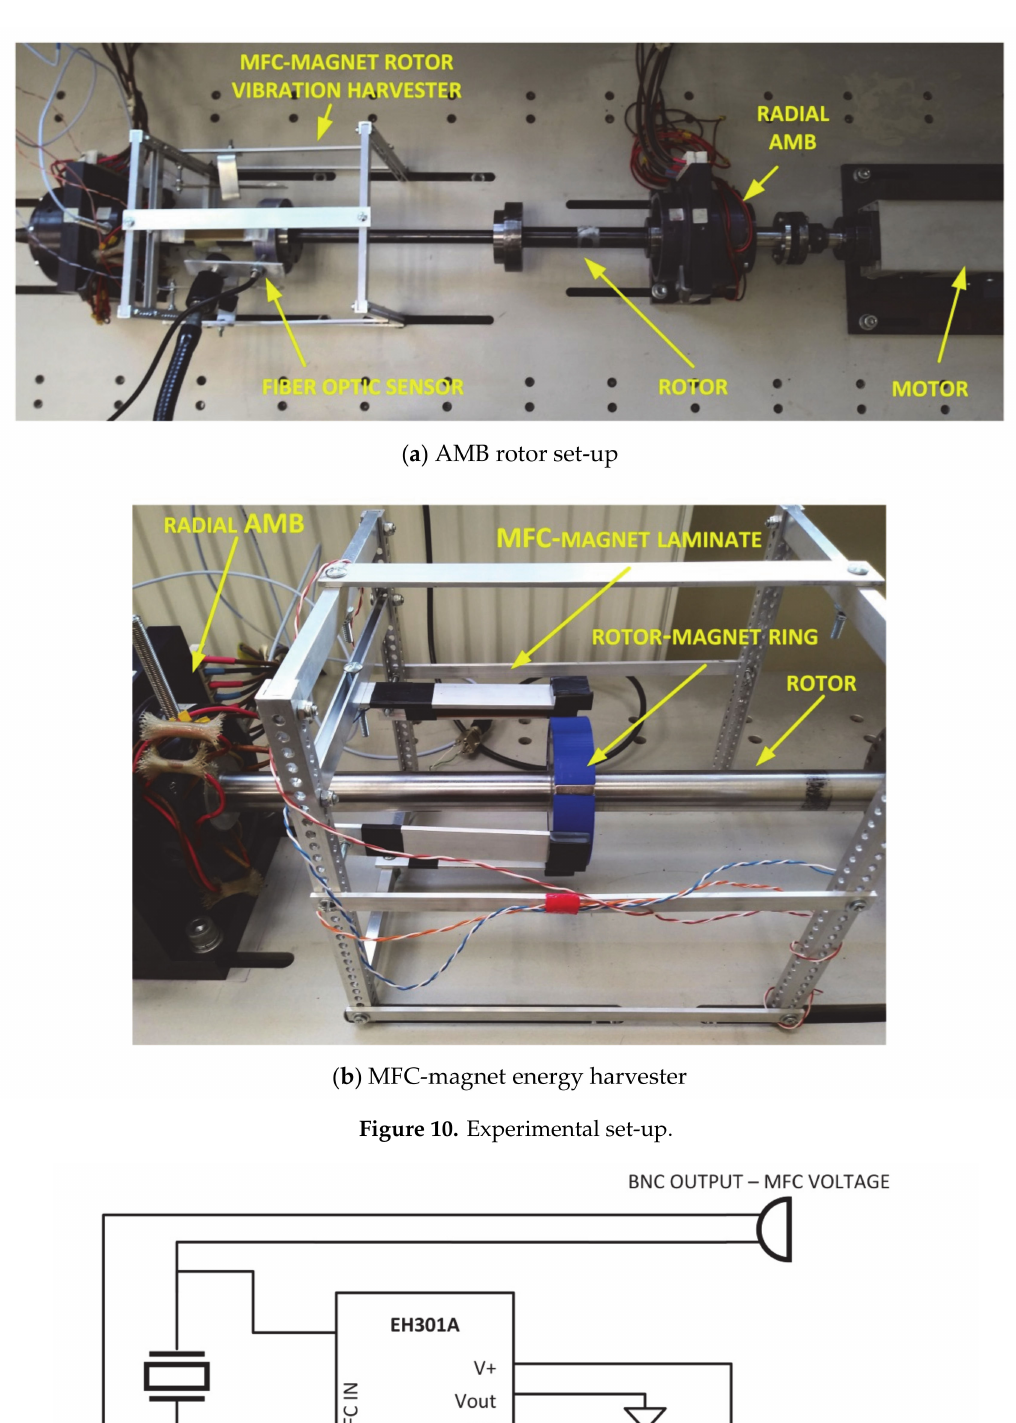
Figure 11. MFC and energy storage